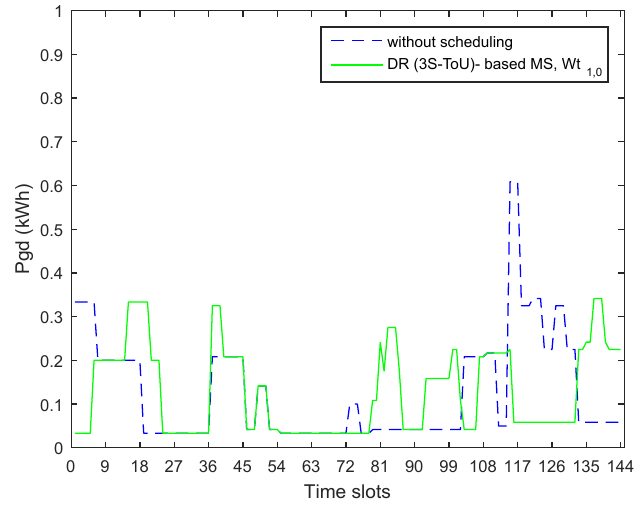
Figure 12. Load profile with maximal reduction in CE for 3S-ToUP